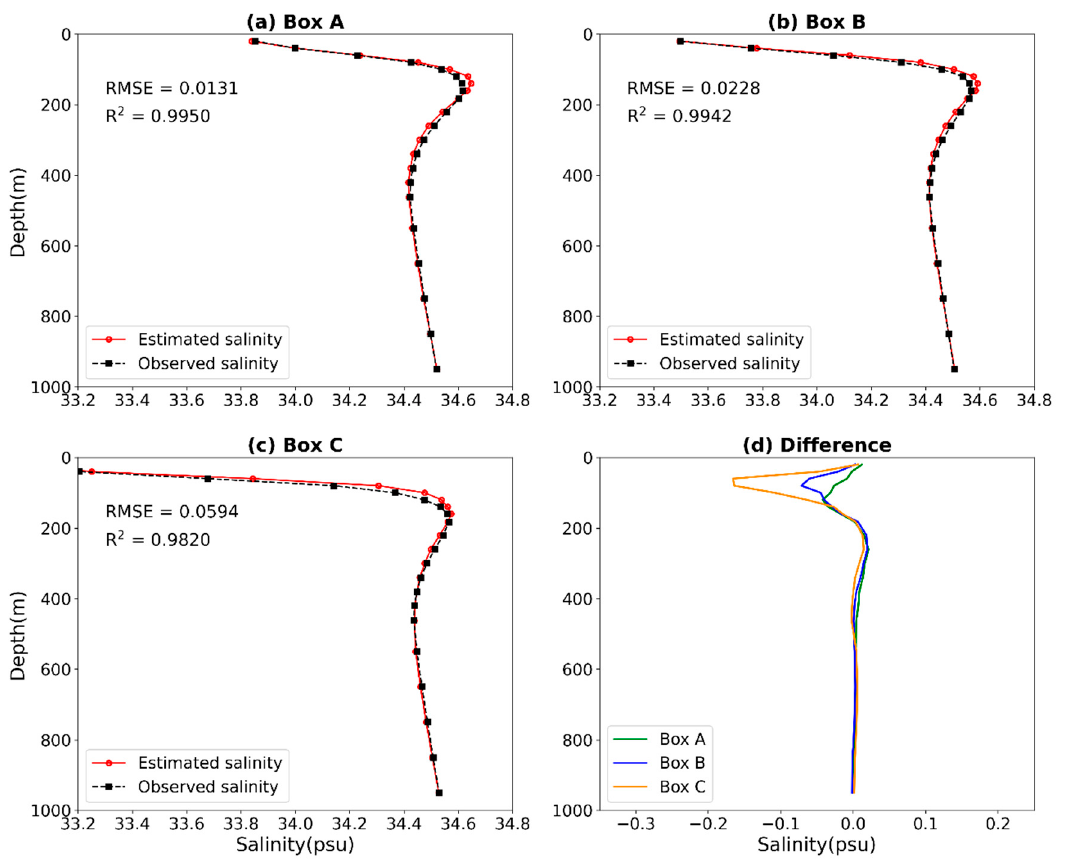
Figure 10. Comparison of the LGB-DF-estimated and Argo-observed salinity profiles averaged at different depths in Boxes (A–C) in 2019 ( a – c ) and their differences ( d ); Box A (116°E~118°E, 19°N~21°N), Box B (110.5°E~112.5°E, 15°N~17°N), and Box C (114°E~116°E, 9°N~11°N).